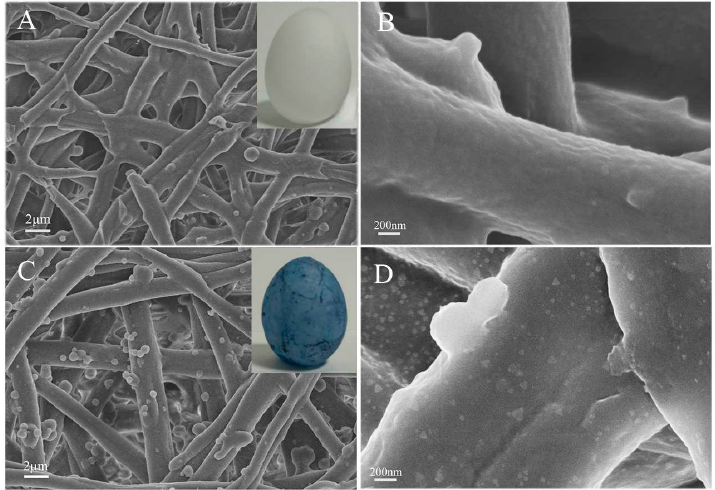
Figure 2. Scanning electron micrographs of pristine ESM ( A , B ) and the as-prepared AgNP@ESM composites ( C , D ) at different magnifications.